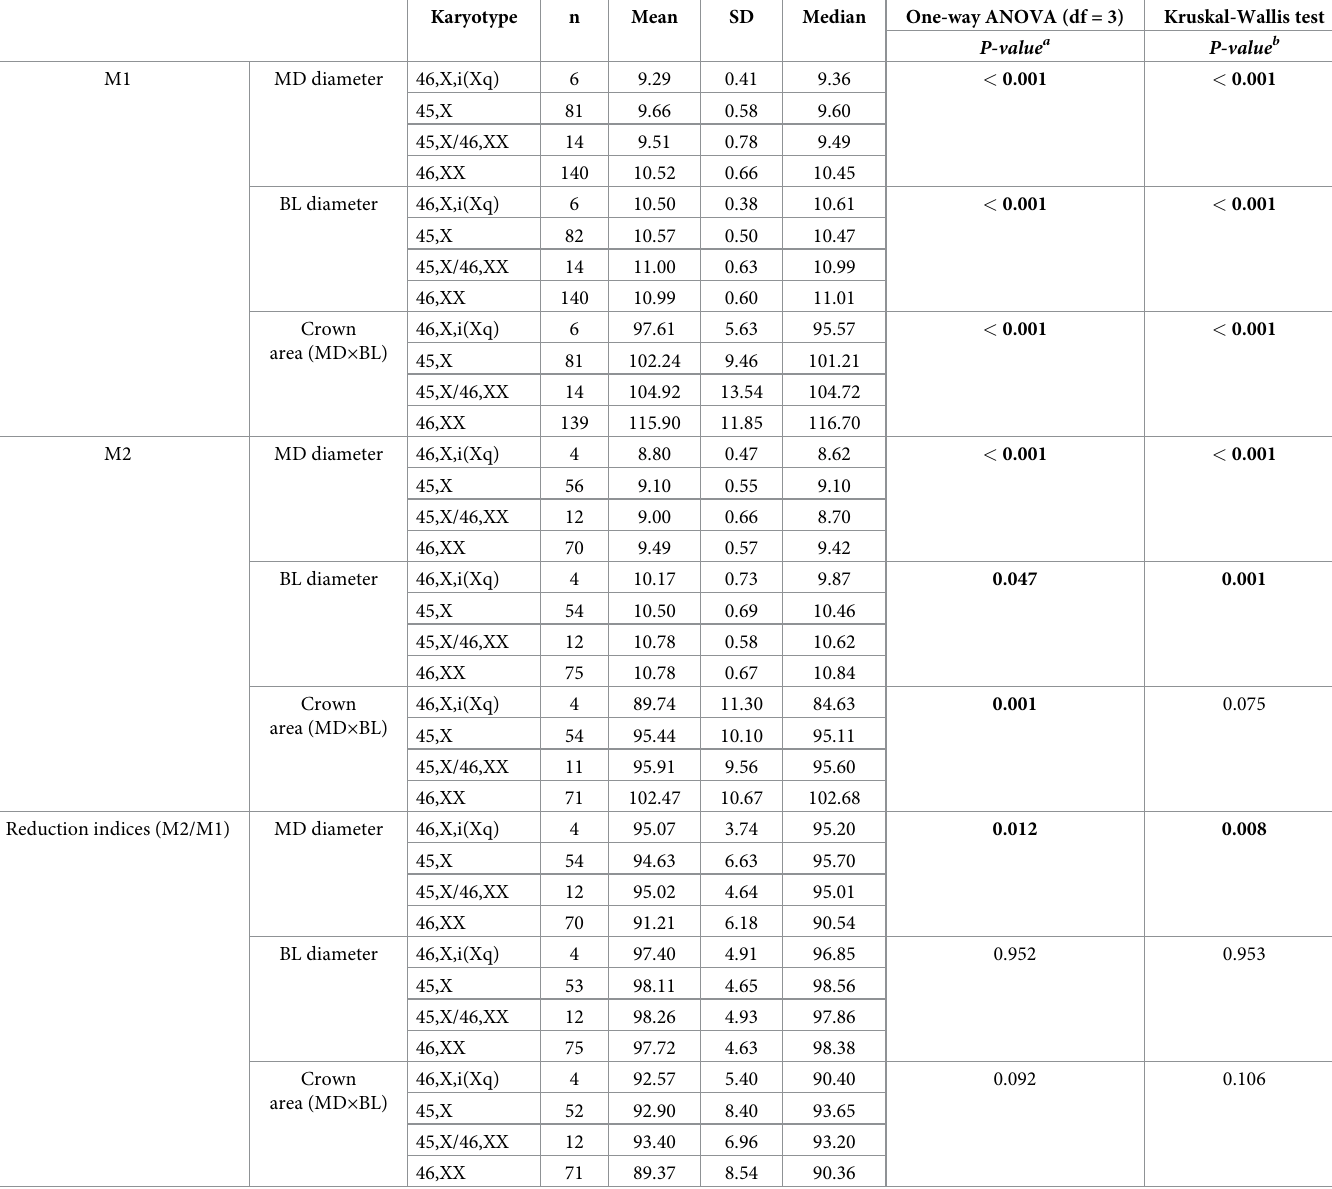
Table 1. Basic statistics of the tooth crown diameters (mm), crown area (mm 2 ), tooth shape, and reduction indices in the study